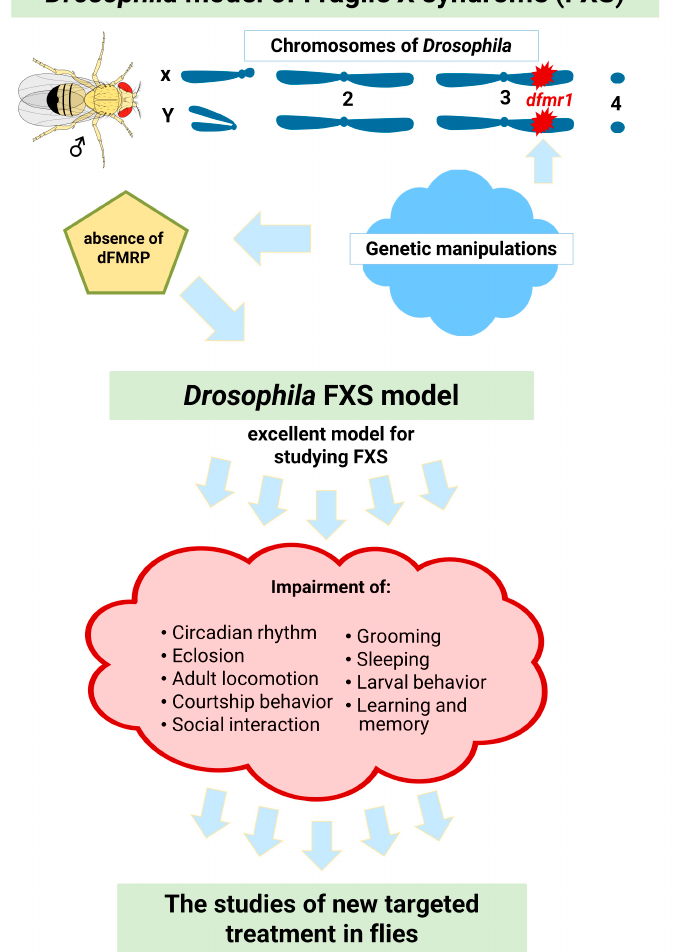
Figure 2. Drosophila model of fragile X syndrome (adapted from reference [21]). Aberrations: dfmr1 -Fragile X Messenger Ribonucleoprotein 1 gene in Drosophila; dFMRP-d fmr1 protein in Drosophila ).